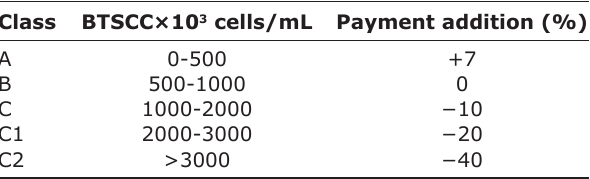
Table-1: Additional payment rate based on BTSCC for each class in